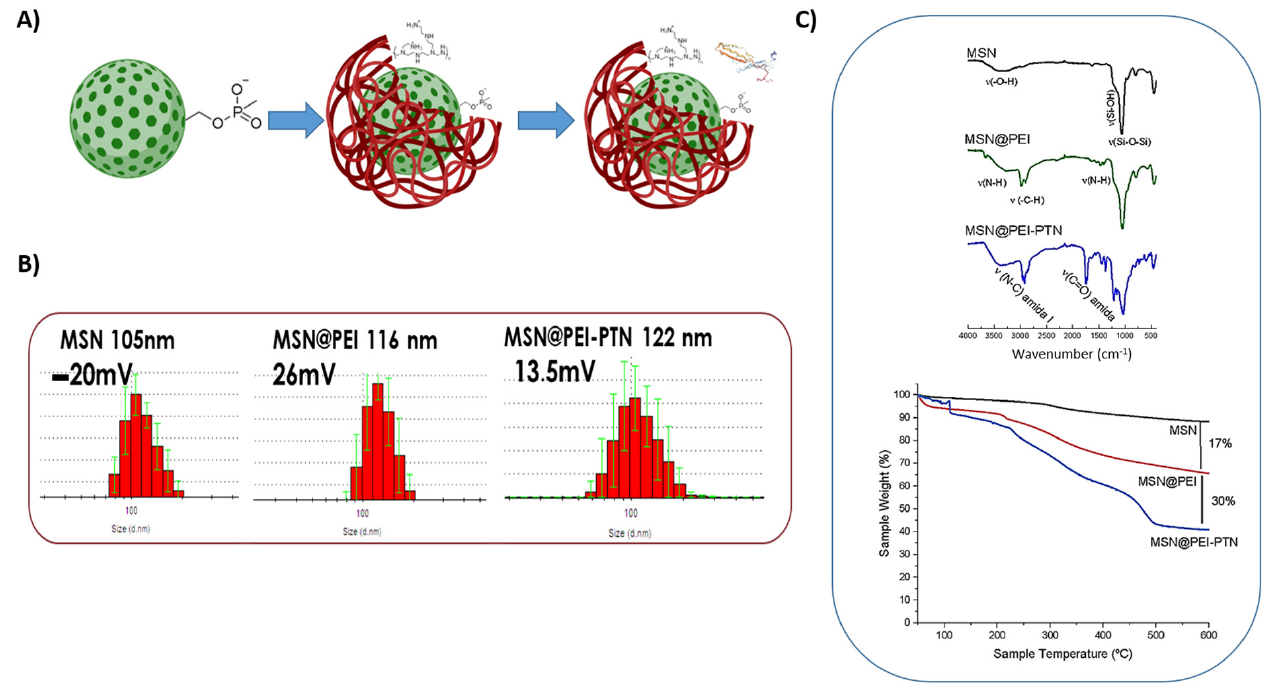
Figure 2. Synthesis and characterization of MSN@PEI-PTN nanosystems. ( A ) Schematic representation of the designed nanocarrier based on mesoporous silica nanoparticles with and without PEI and pleiotrophin (PTN). ( B ) The ζ potential and DLS analysis. ( C ) Fourier Transformed Infrared spectroscopy (FTIR) and thermogravimetric analysis (TGA) of MSN@PEI before and after loading with PTN peptide.